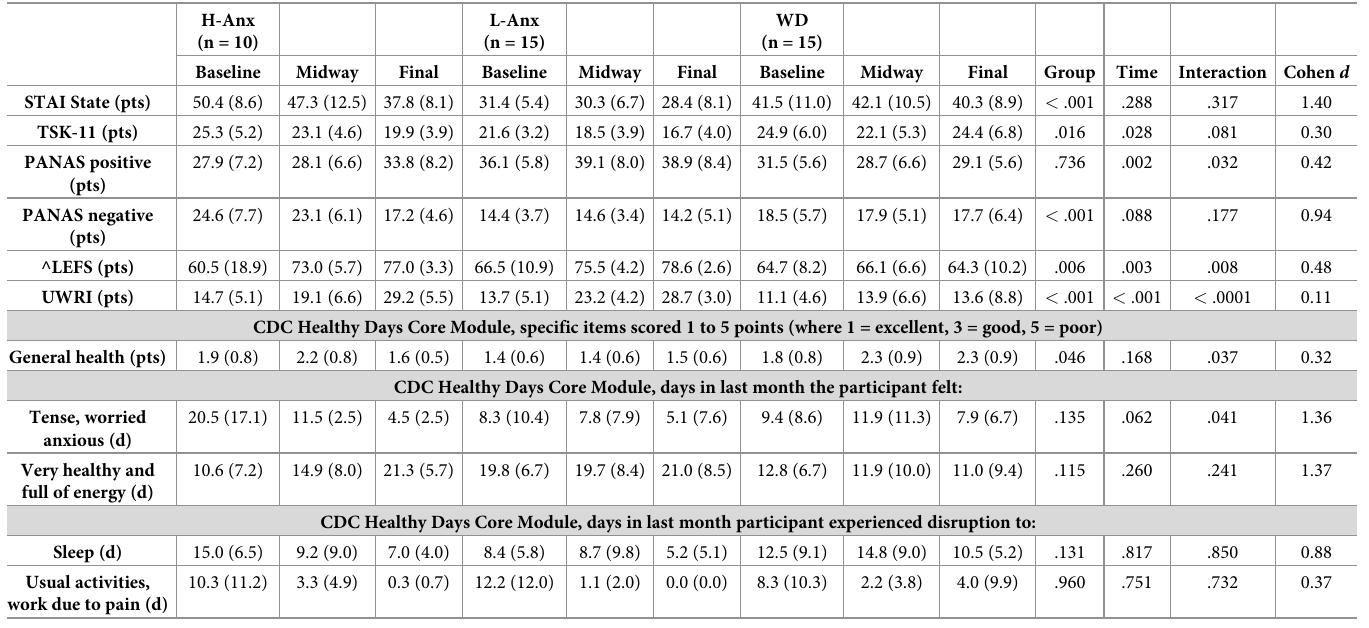
Table 2. Psychological well-being in injured runners with and without high anxiety levels and runners who withdrew (WD). Values are means (SD). H-Anx L-Anx WD (n = 10) (n = 15) (n = 15) Baseline Midway Final Baseline Midway Final Baseline Midway